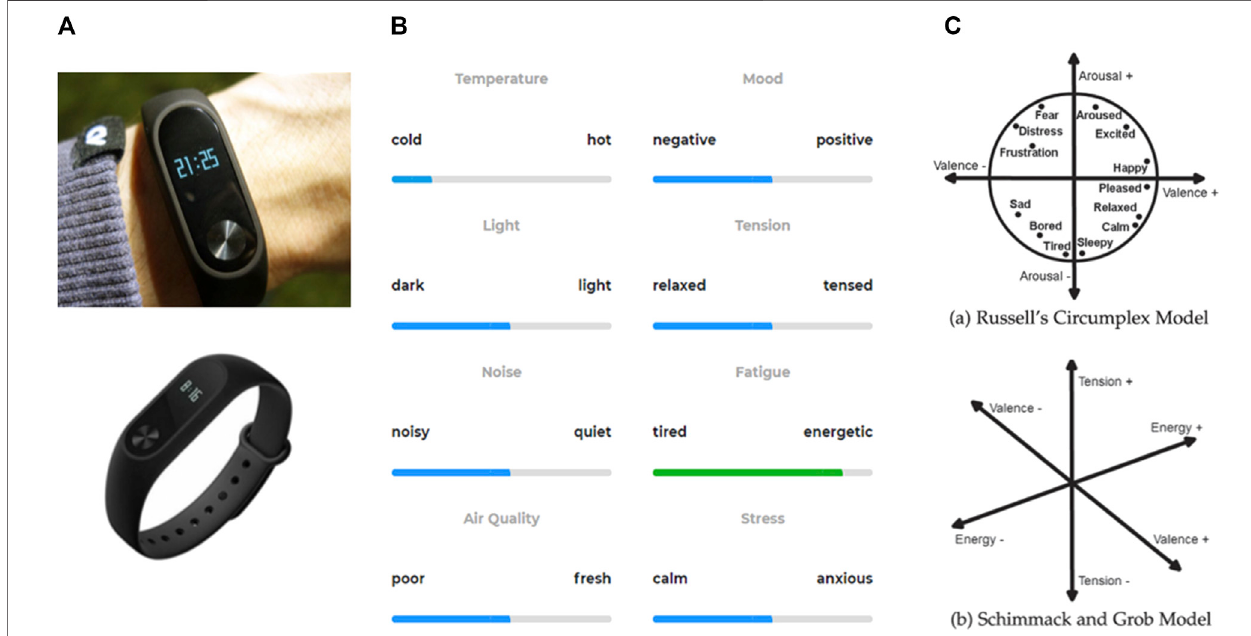
FIGURE 2 | A Mi Band 2 wearable used for the study, B Purpose-build sliders for self-reporting, C dimensions of affect models.